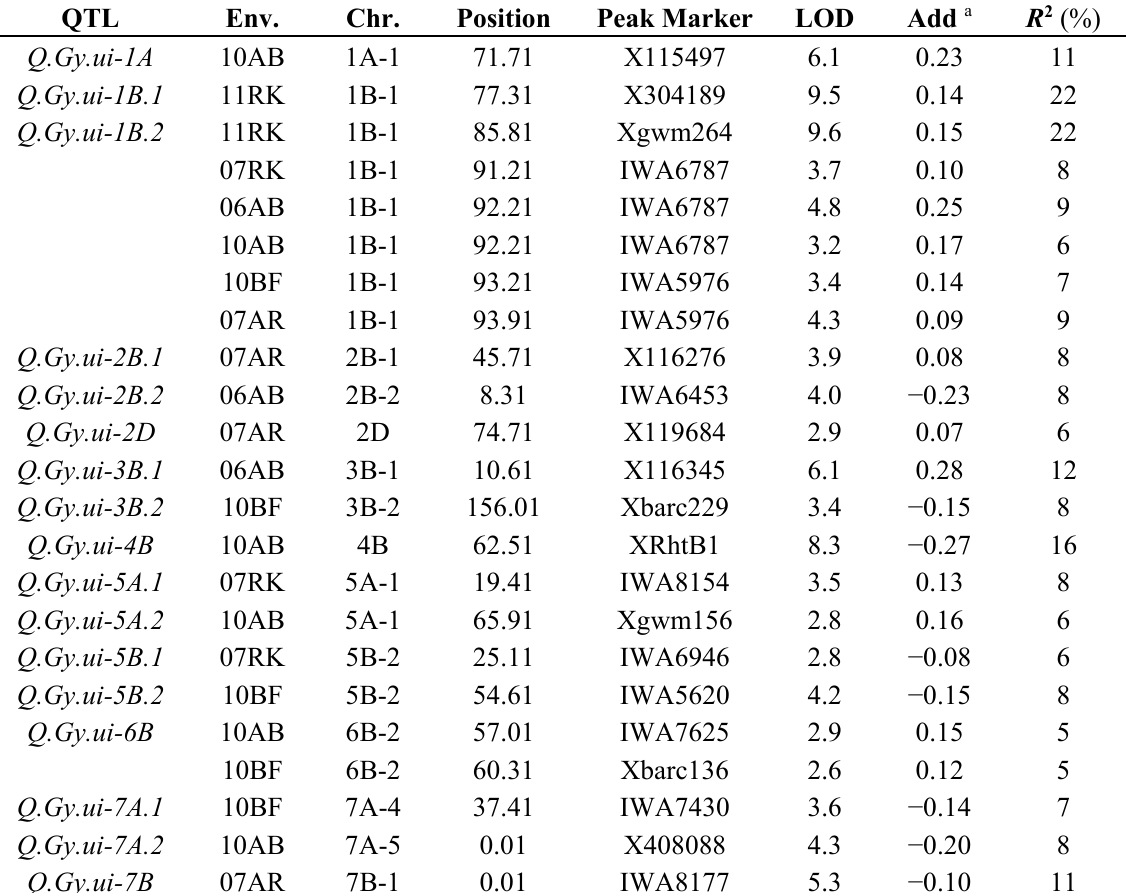
Table 3. QTL of grain yield identified in Rio Blanco/IDO444 population in six environments.